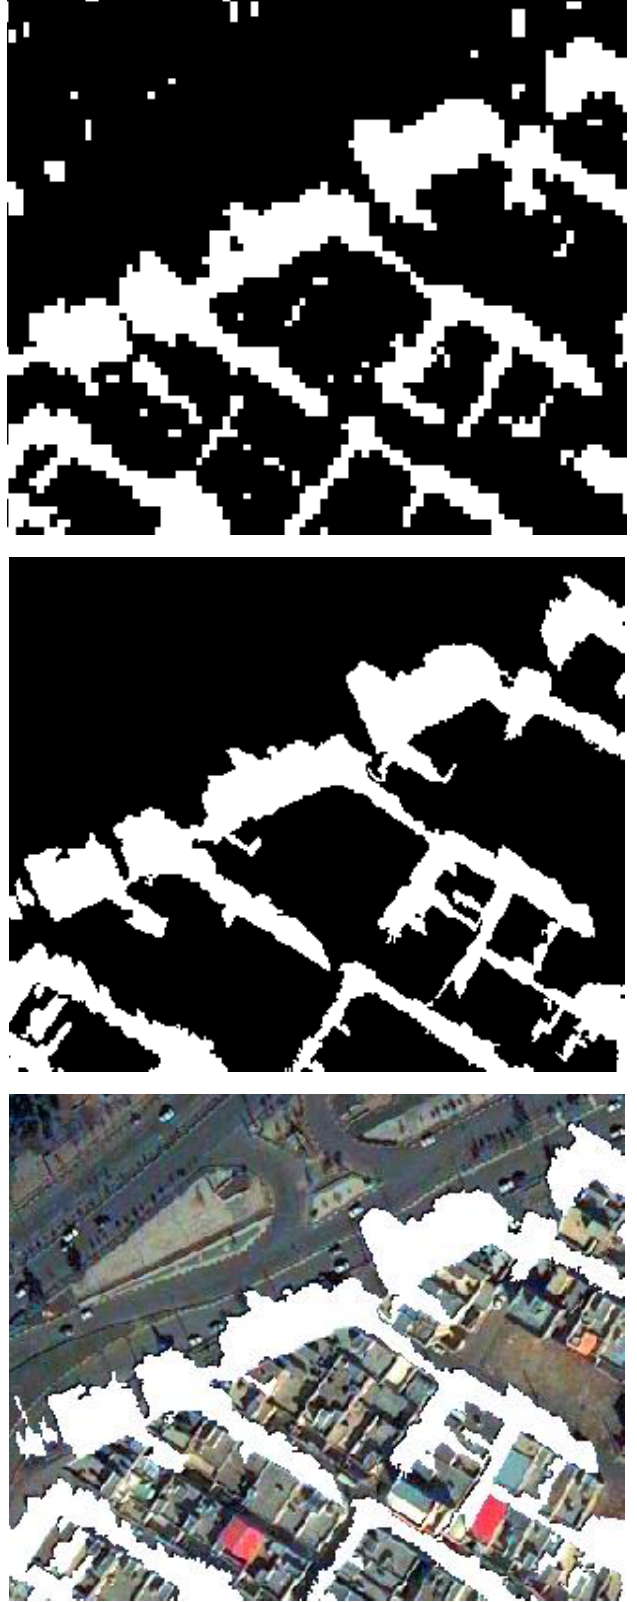
Figure 6. Shadow detection result in pixel and object level